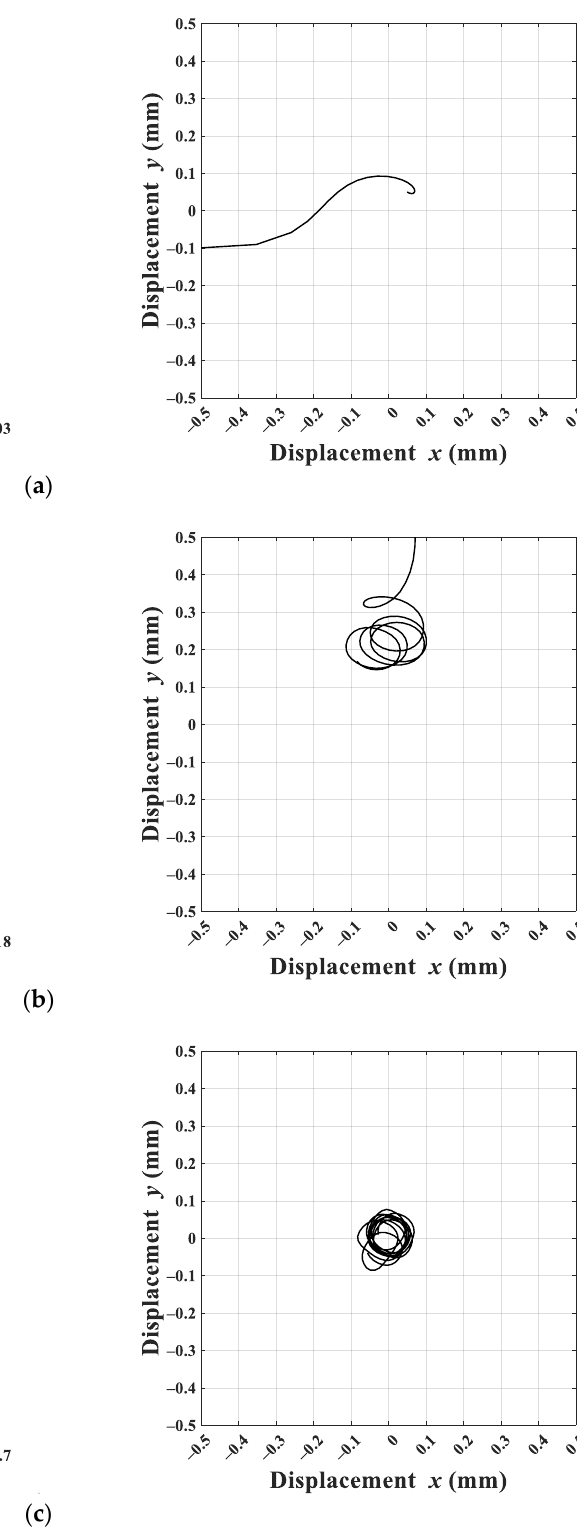
Figure 8. Last 10 cycles of rotor response for ρ = 0.06 mm, ω = 250 rad/s, x 0 = y 0 = 0.05 mm: ( a ) PD controller, ( b ) FLC, ( c ) FBBRC.